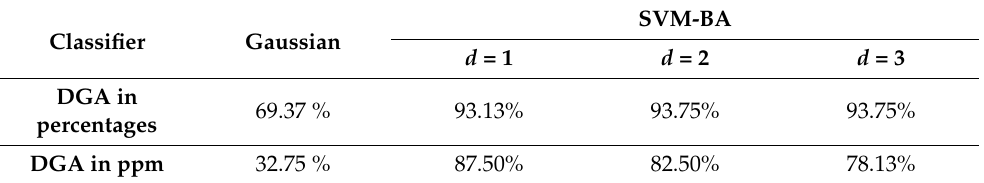
91% and 94%. The global best results related to the accuracy rate obtained for several runs are presented in Table 4. Additionally, DGA has been elaborated in ppm and percentages for the input vector. Table 4. The accuracy rate for both classifiers after 50 executions.